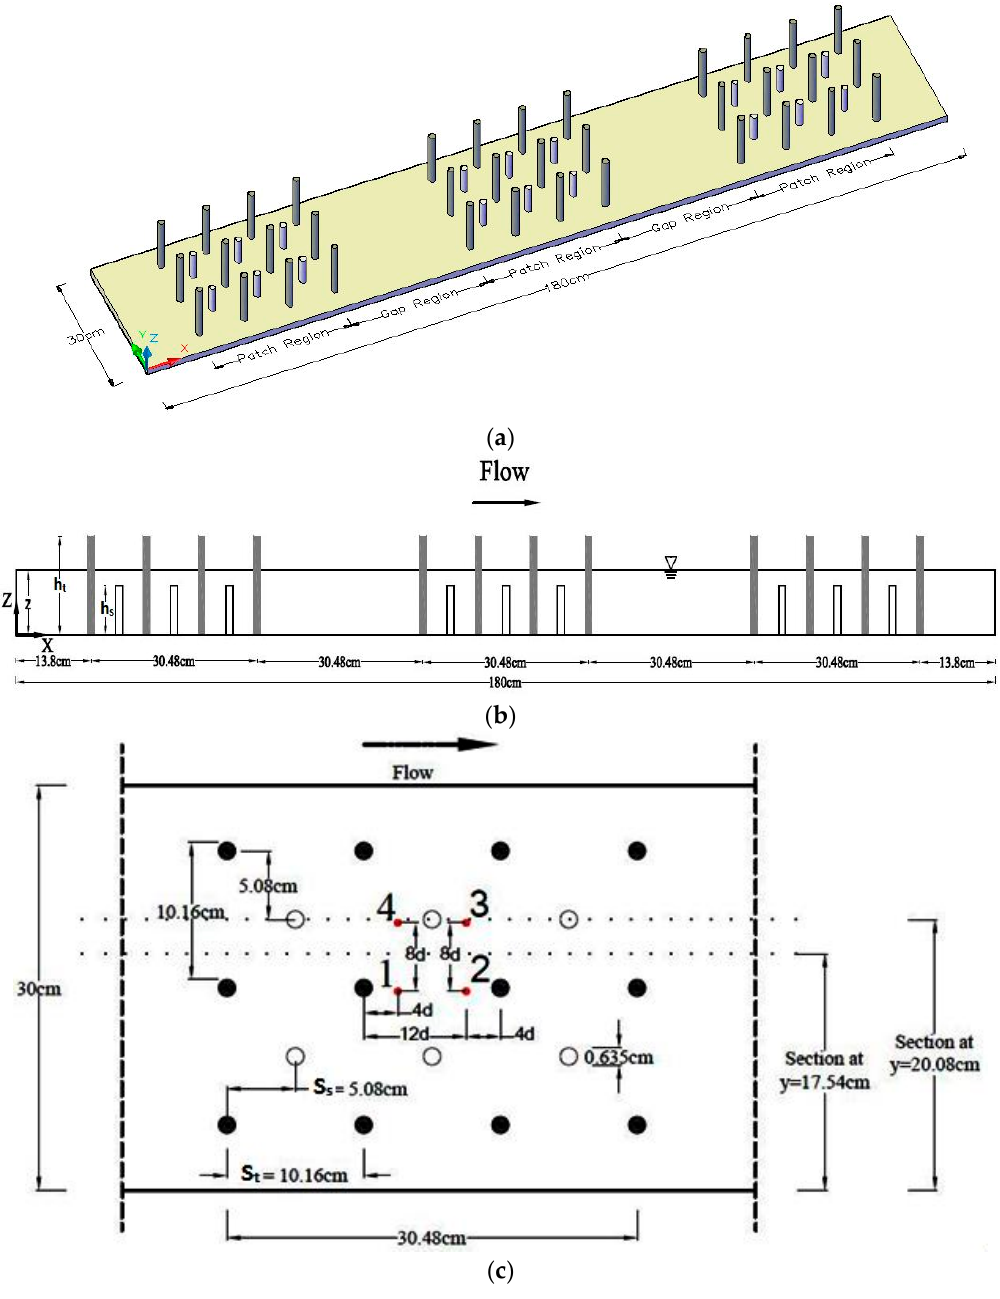
Figure 3. Schematic diagrams of the domain: ( a ) isometric view of the domain; ( b ) vertical section of the discontinuous patch configuration; and ( c ) top view of the last vegetation patch showing critical locations in red color (i.e., Locations 1, 2, 3, and 4).